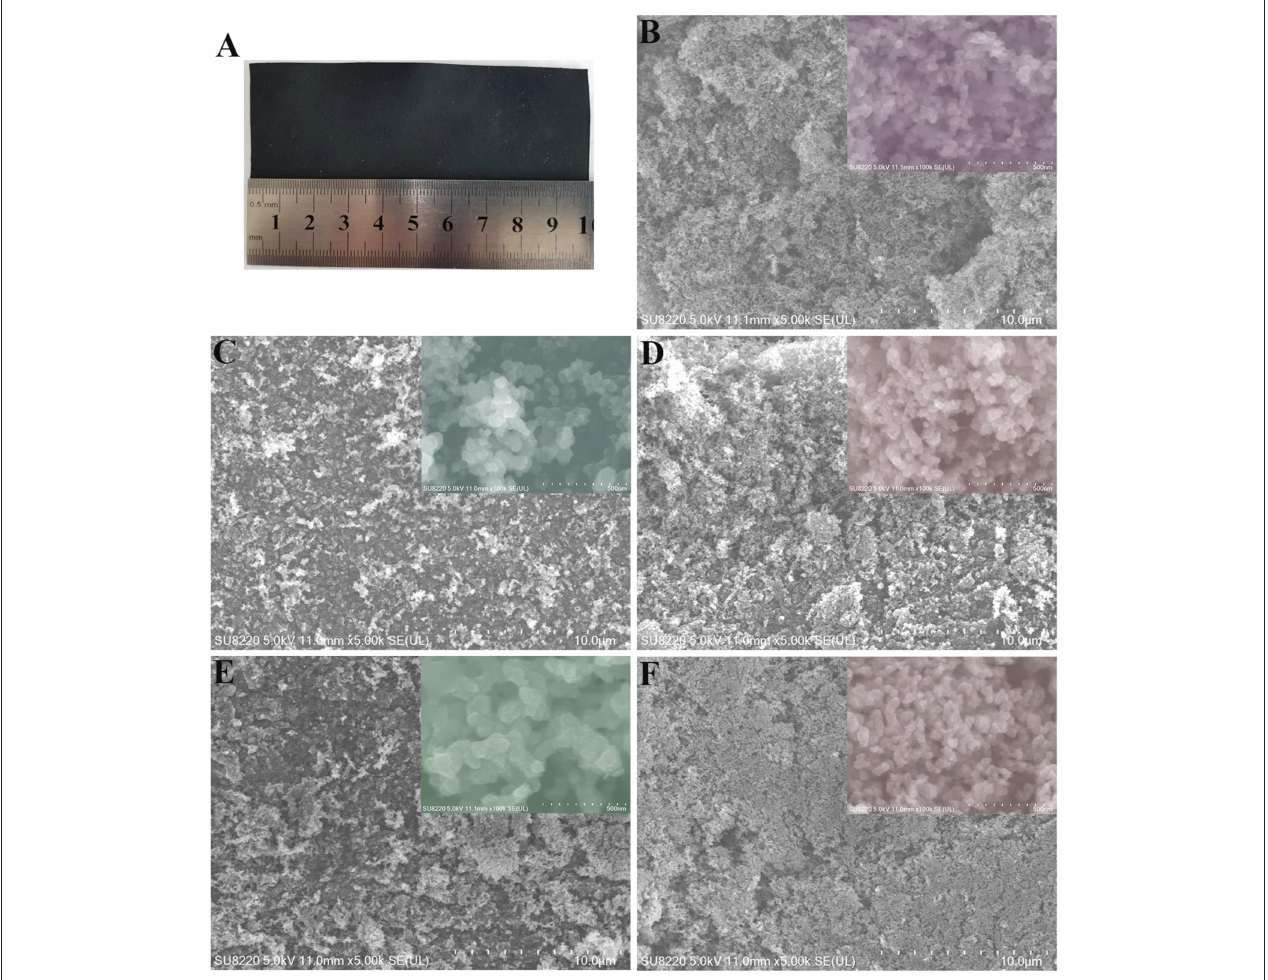
FIGURE 1 | (A) Cathode carbon support, SEM images of carbon supports after annealing [ (B) : carbon support with 0% NH 4 HCO 3 , (C) : carbon support with 1% NH 4 HCO 3 , (D) : carbon support with 3% NH 4 HCO 3 , (E) : carbon support with 5% NH 4 HCO 3 , (F) : carbon support with 7% NH 4 HCO 3